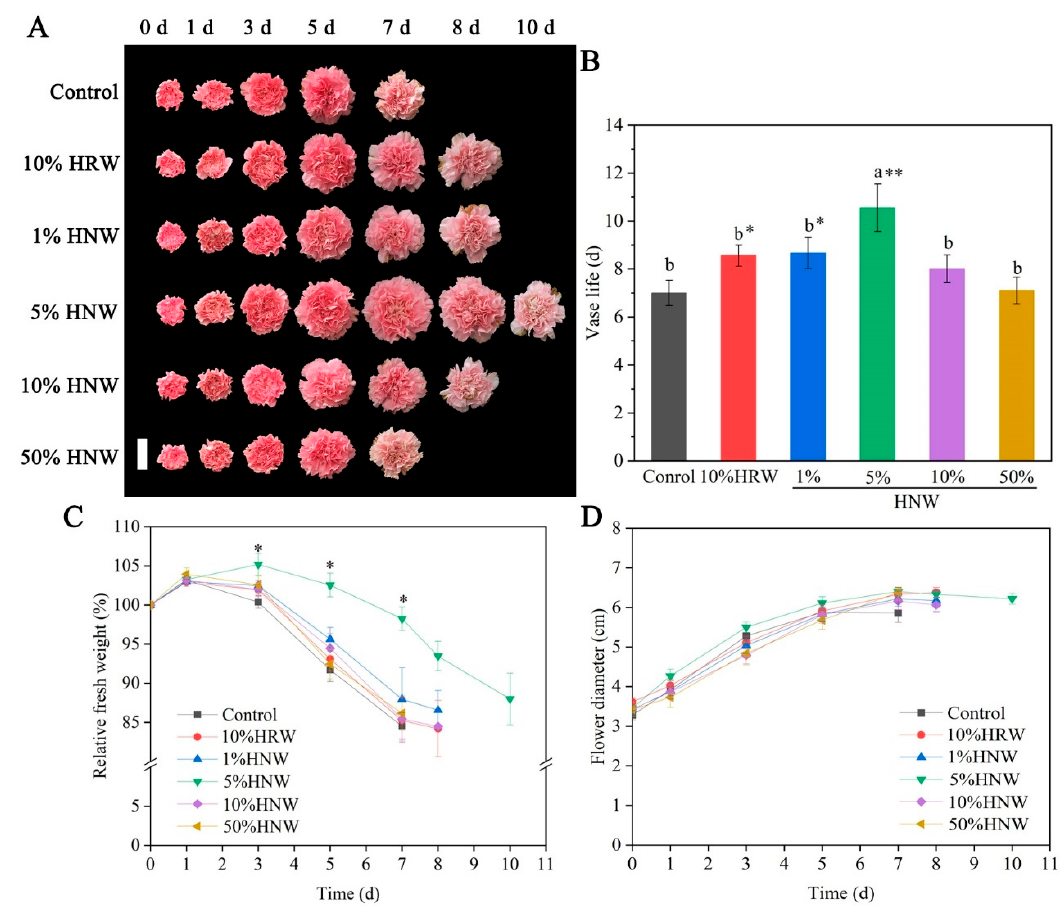
Figure 2. Effects of different concentrations hydrogen nanobubble water (HNW) and 10% hydrogen-rich water (HRW) on morphological changes ( A ), vase life ( B ), relative fresh weight (RFW; ( C )), and flower diameter ( D ) of cut carnation flowers. Cut flowers were incubated in distilled water (control), 1%, 5%, 10%, and 50% HNW, and 10% HRW for 3 d (changed daily), and then, in distilled water, which was replaced daily until the end of experiments. Representative photographs of cut flowers were taken (scale bar = 4 cm). Afterward, vase life ( B ), RFW ( C ), and flower diameter ( D ) were expressed as mean ± standard error (SE). There were three replicates and three flowers per each. Experiments were conducted three times. The different letters in a column indicated significant differences according to Duncan’s multiple range test ( p < 0.05), and asterisks indicated significant differences in comparison with the control at p < 0.05 (*) or 0.01 (**) according to t